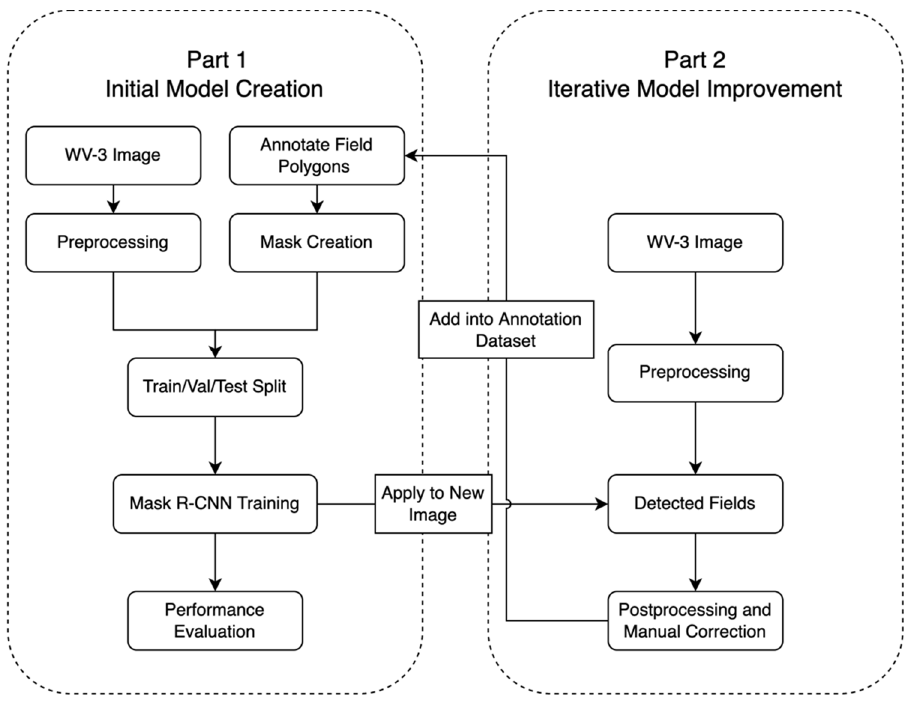
Figure 2. Workflow of building the Mask R-CNN models using WV-3 in Bihar .